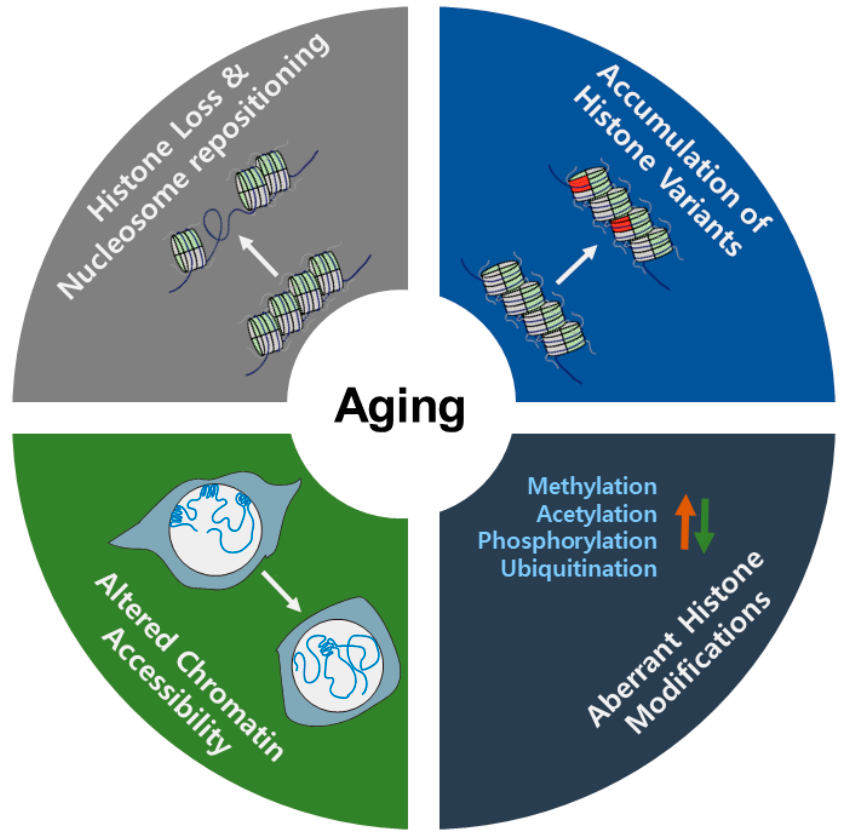
Figure 1. Changes in chromatin states linked to aging.